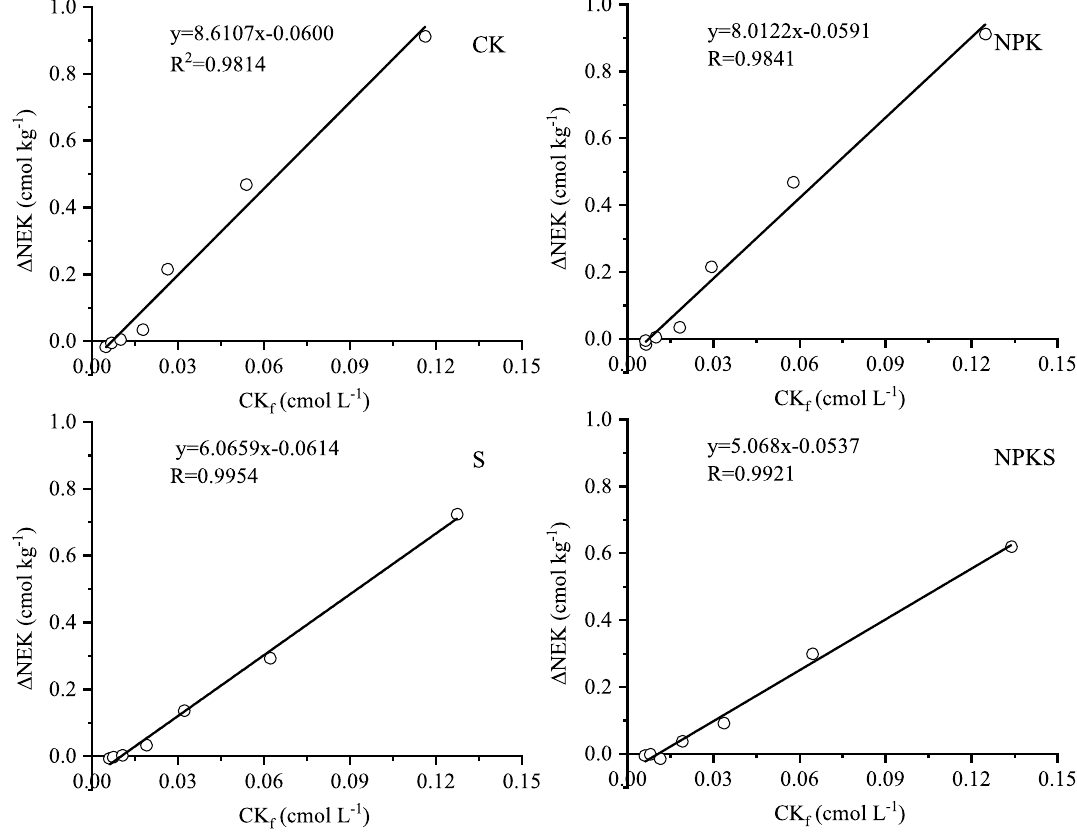
Figure 7. Plots of ∆NEK versus CK f for tested soils with and without straw return. (CK, no fertilization; NPK, mineral fertilizing; S, straw 6000 kg h m −2 ; NPKS, NPK with straw 6000 kg h m −2 ; ∆NEK, amount of K adsorbed or release due to non-exchangeable pool of K during equilibration; CK f , Potassium concentration in soil solution after equilibration period).